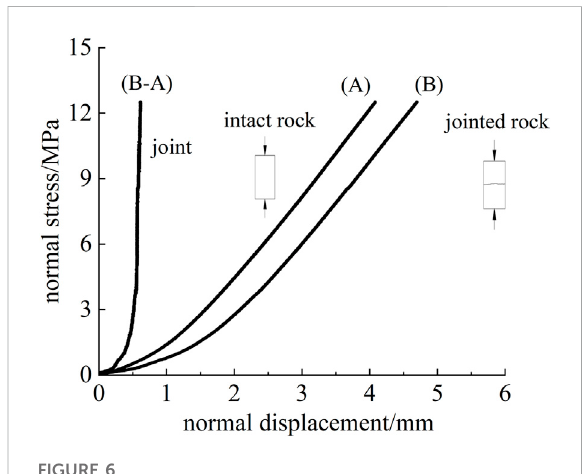
FIGURE 6 Normal deformation of a rock joint with a JRC of